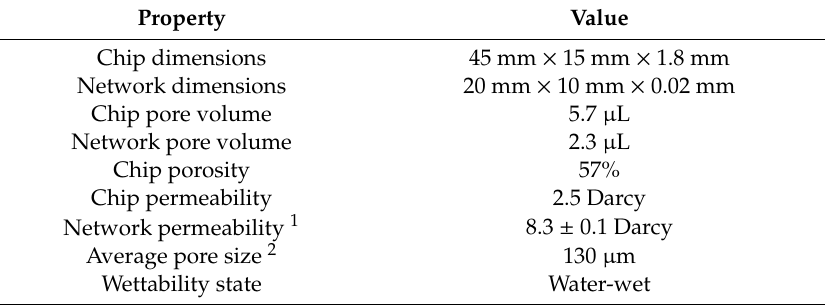
Table 1. Dimensional and petrophysical properties of the porous medium.